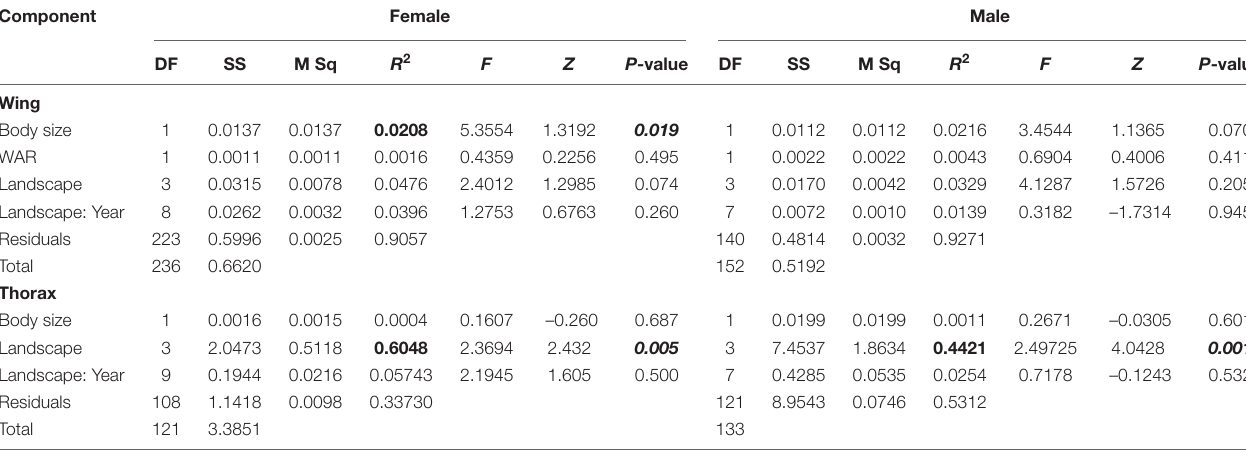
TABLE 2 | Results of ANOVA for a LMM for wing and thorax size (as Cs) of T. dimidiata. Component Female